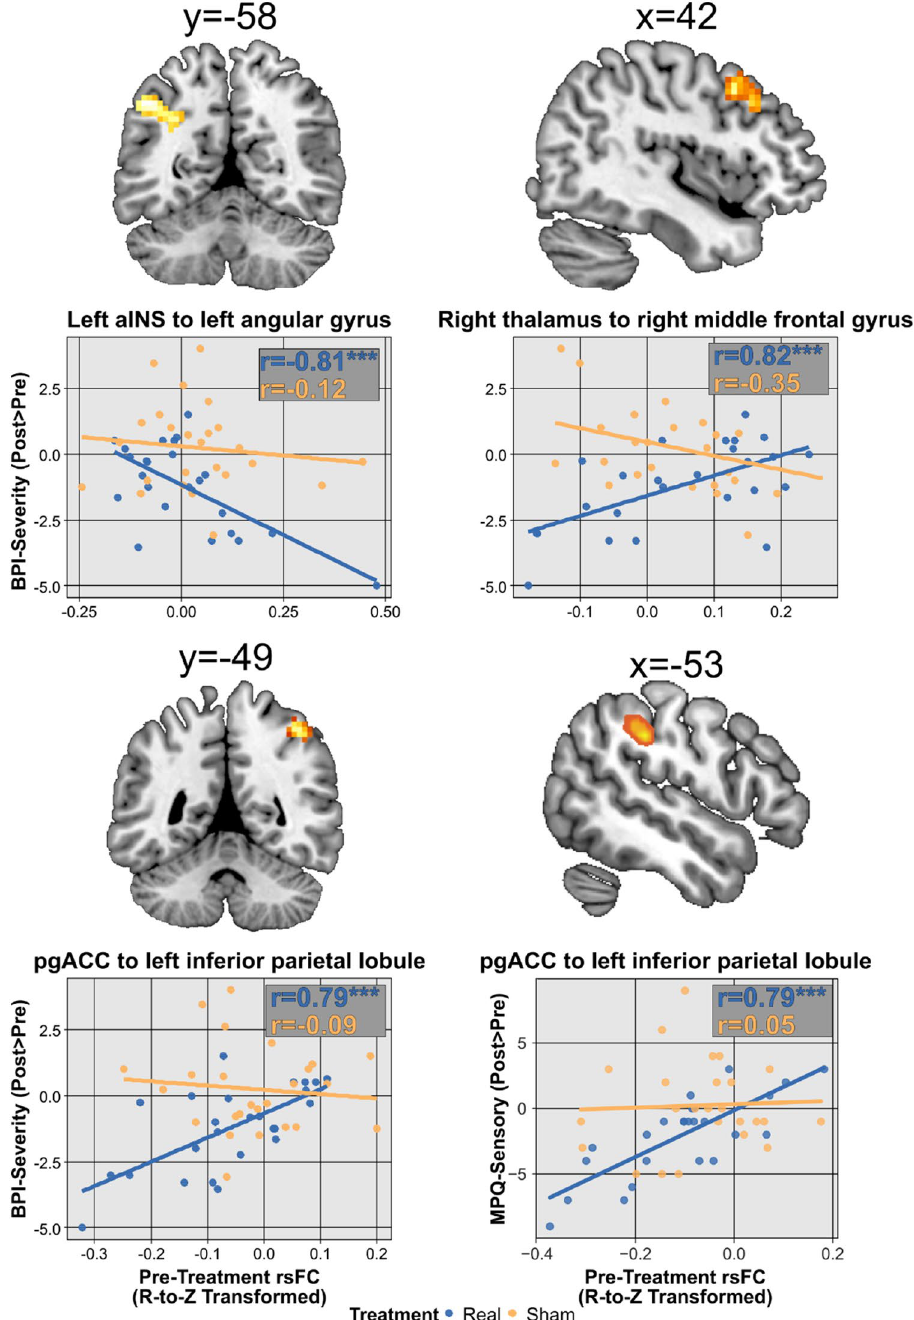
Figure 3. rsFC of ascending nociceptive and descending pain inhibition brain areas BPI-Severity predict reductions following real, but not sham, M1-rTMS. Coordinates in upper panels are in MNI space. aINS anterior insula r, Pearson’s correlation coefficient, pgACC pregenual anterior cingulate cortex. ***p <